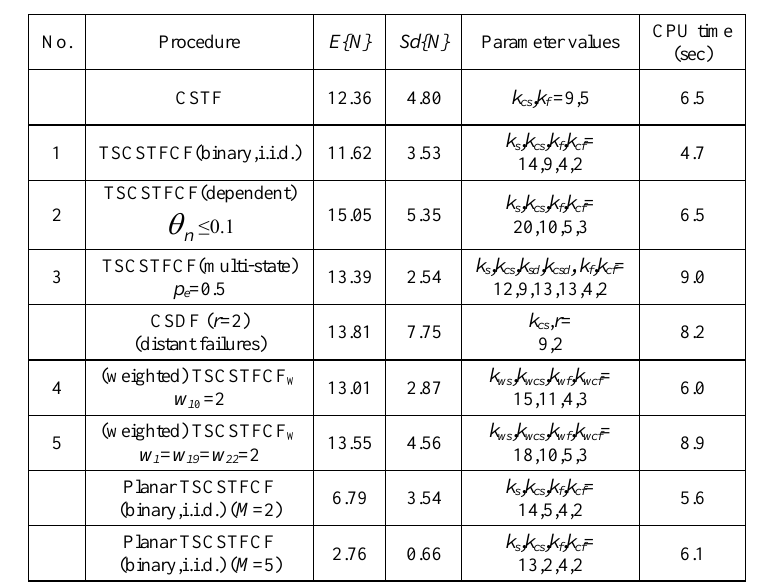
Table 5.Optimal values of the expected number of tests for different